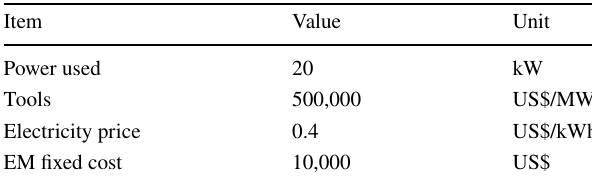
Table 3 Economic parameters for EM heating